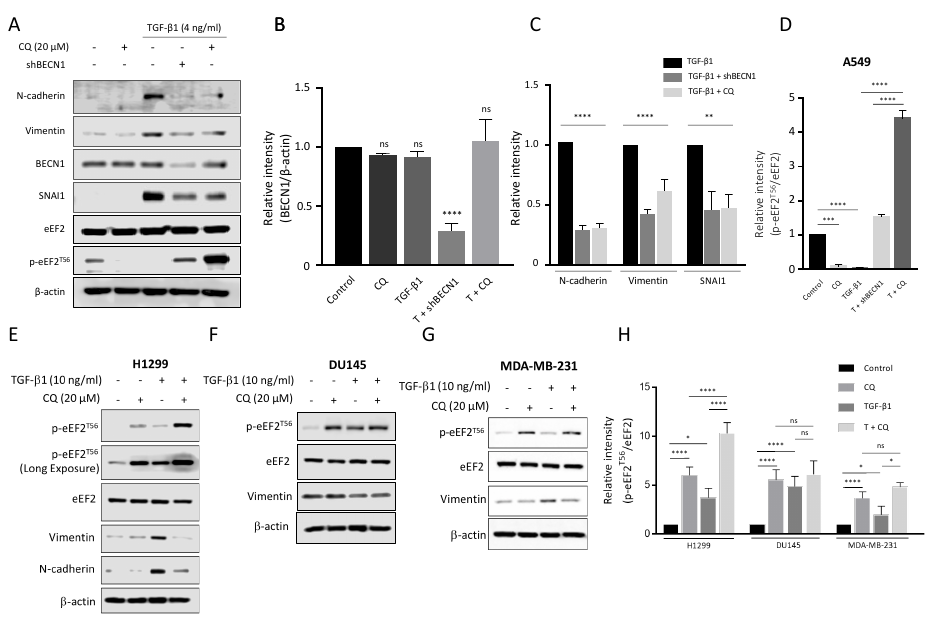
Figure 4. Blockage autophagic flux under TGF- β 1 inhibits mesenchymal protein expression and stimulates phosphorylation of eEF2 at T56 in cancer cells. ( A ) Western blotting. A549 cells were transfected with sh BECN1 or shRNA (eGFP) control plasmid and treated with TGF- β 1 4 ng/mL with or without 20 µ M chloroquine (CQ) for 24 h. The relative amounts of BECN1 ( B ), other EMT proteins ( C ), and phosphorylated eEF2 at T56 ( D ) in A549 cells were quantified against β -actin using NIH ImageJ software. ( E – G ) Western blotting. H1299, DU145, and MDA-MB-231 cells were treated with 10 ng/mL TGF- β 1 in the presence or absence of 20 µ M chloroquine (CQ). After Western blotting, EMT markers and phosphorylated eEF2 at T56 were detected using their primary antibodies as indicated. ( H ) The relative intensity of p-eEF2 (T56) to total eEF2 in each cancer cell was quantified using ImageJ software. **** p < 0.0001, *** p < 0.001, ** p < 0.01, * p < 0.05, ns indicates not significant p -value. Statistical test was determined by one-way ANOVA followed by Turkey’s test. Data indicate the mean values ± s.d of at least three independent